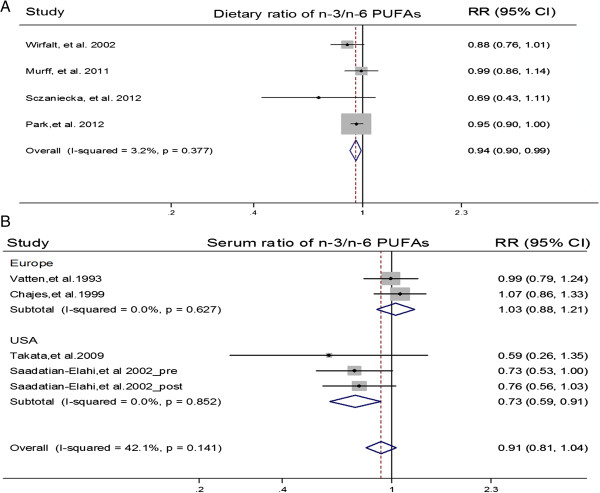
Forest plot of per 1/10 increment of n-3/n-6 PUFAs ratio in diet and serum PL. Prospective studies eligible for dose–response analysis are referred to by first author and year of publication. The relative risks (RRs) are represented by the squares (the size is proportional to the weights used in the meta-analysis), and confidence intervals (CIs) are represented by the error bars. P values and I square for heterogeneity test were shown by using random effect model. The diamonds can separately represent the pooled RR for association between per 1/10 increment of dietary or serum PL ratio of n-3/n-6 PUFA and BC risk, which was combined by a two-stage random-effect model. Figure A indicated association of BC risk with per 1/10 dietary ratio of n-3/n-6 PUFA, whereas Figure B indicated association of BC risk with pre 1/10 serum PL ratio of n-3/n-6 PUFA.